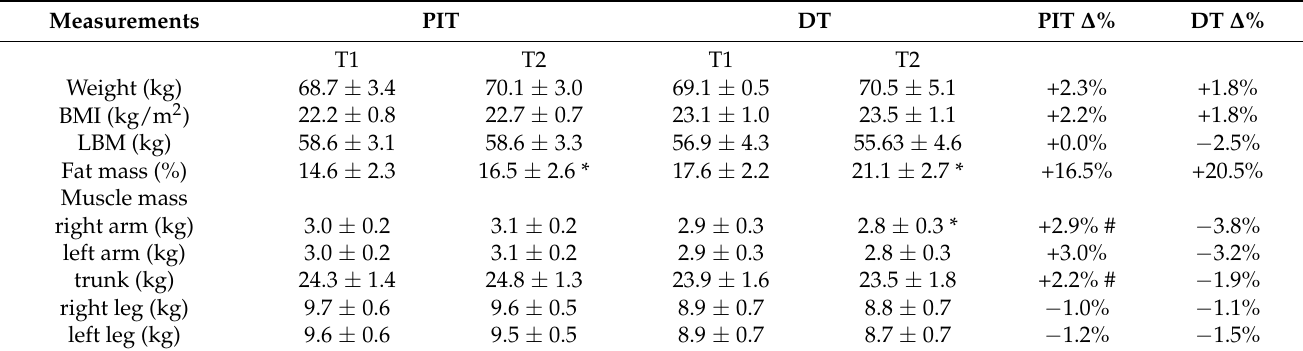
Figure 6. Kicking reaction time results ( A ), flexibility ( B ), 10M sprint ( C ), and VO 2 max ( D ) in T1 and T2. * p < 0.05 vs. T1 under the same condition. Data are expressed as mean ± S.E.M. Table 2. The body composition of PIT and DT.